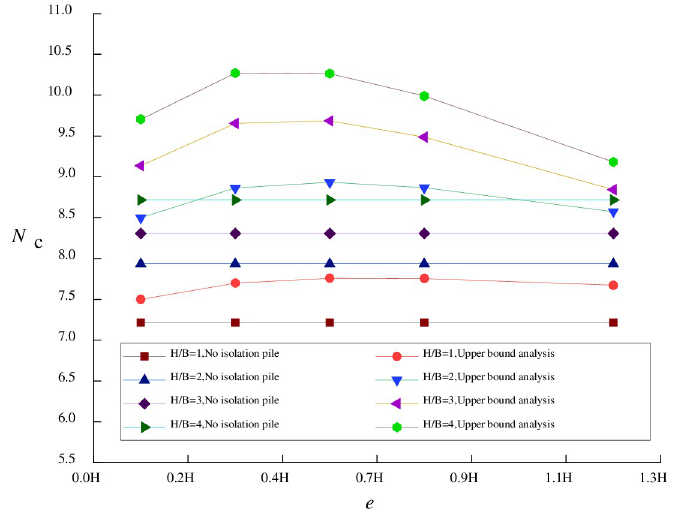
Fig 7. Relationship between the stability coefficient and e ( t =